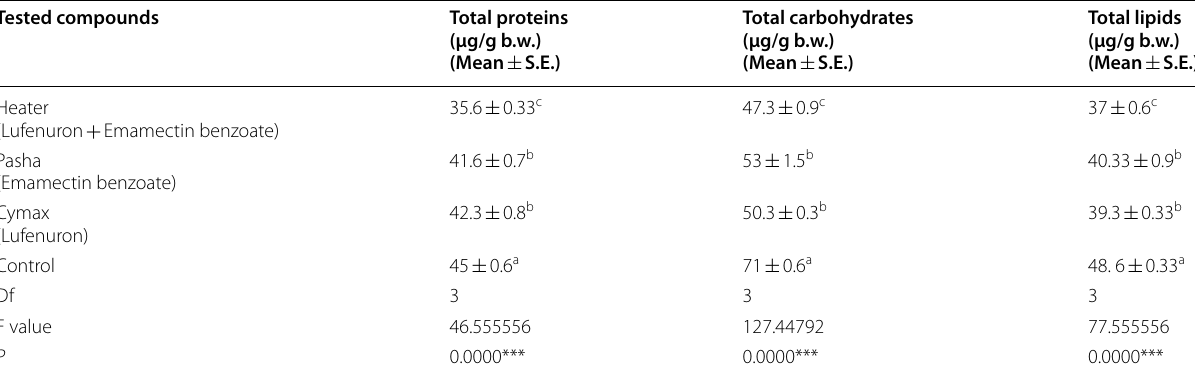
Table 5 Effect of the tested compounds on total proteins, total carbohydrates, and total lipids activity in 4th instar larvae of S . littoralis after treatment with LC 50